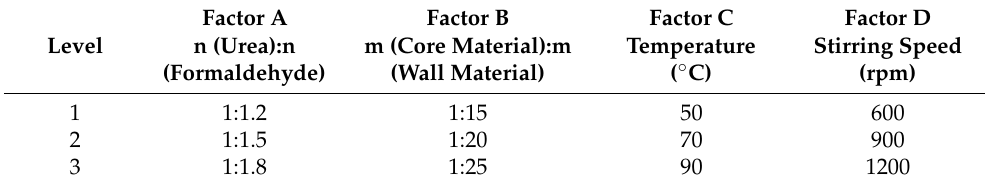
Table 2. Formulation scheme of the orthogonal experiment.